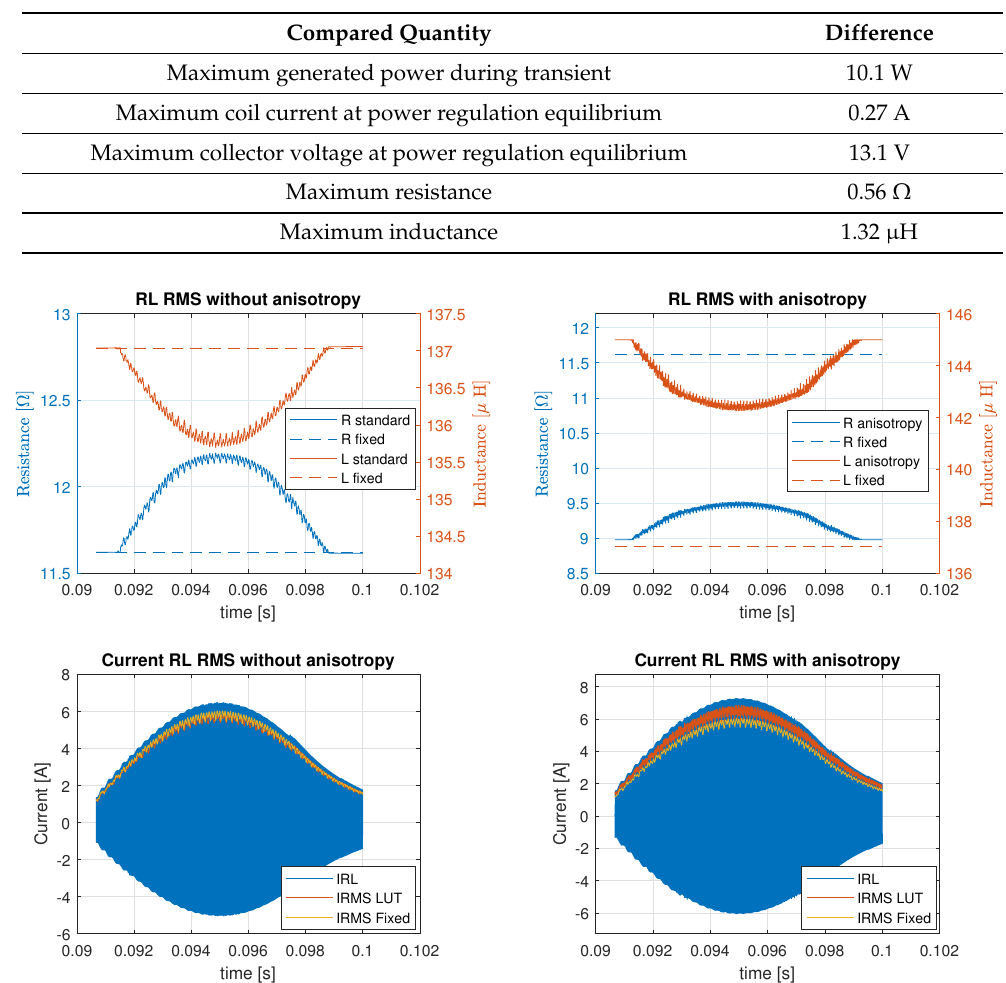
Figure 8. Equivalent rms R − L parameters during an half grid waveform carrier. The variation of the current and frequency in the control horizon generates a variation in the equivalent